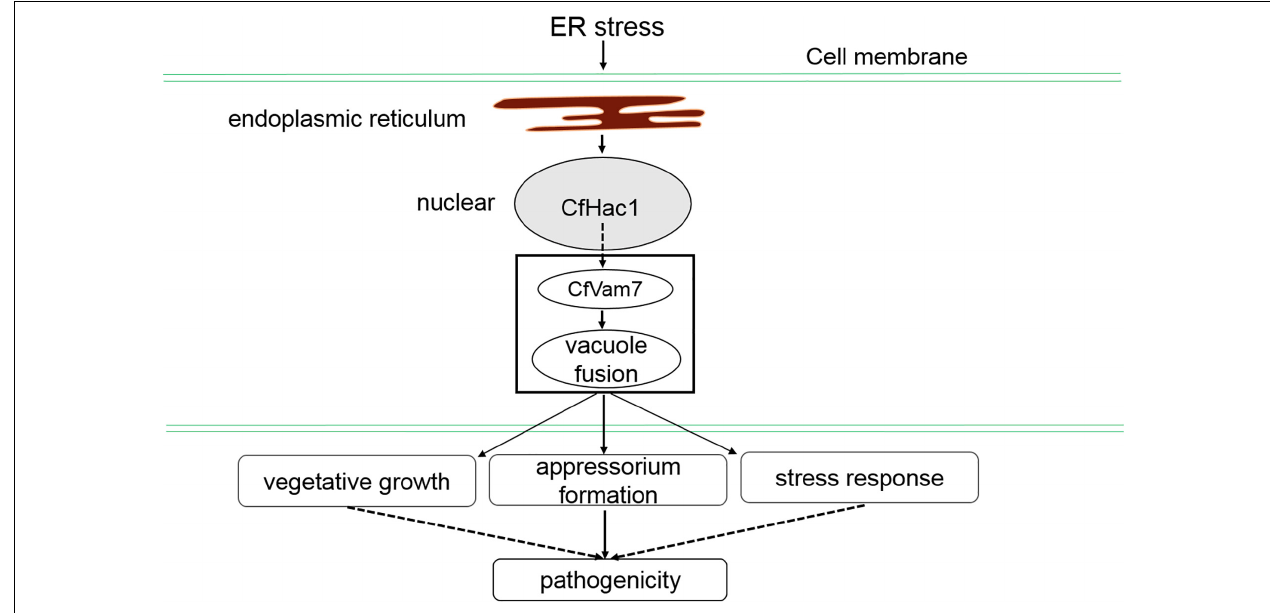
FIGURE 9 | The working model of Cfvam7 in Colletotrichum fruiticola